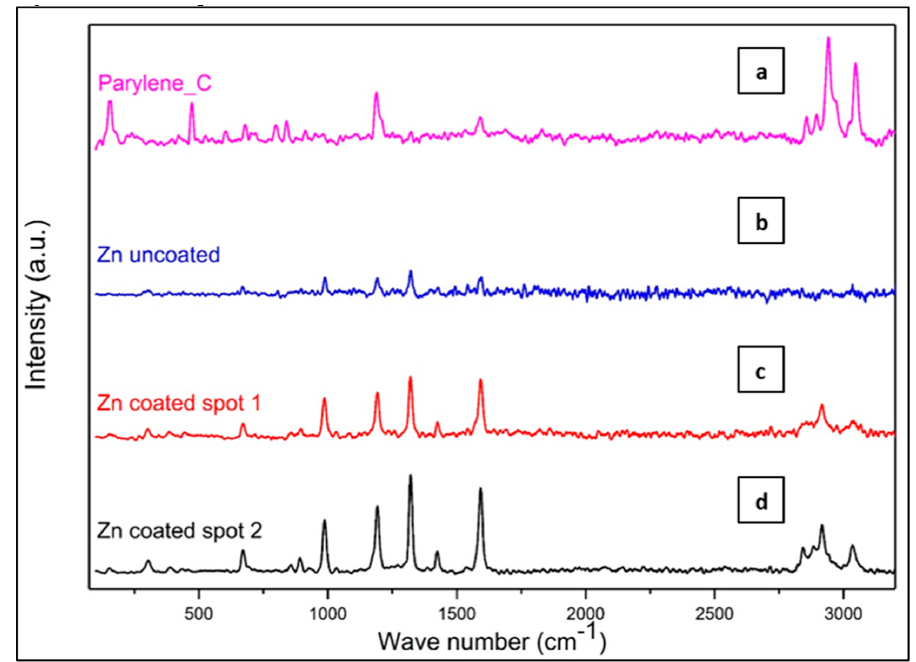
Figure 10. Raman spectroscopy of: ( a ) Parylene_C Dimer as a control; ( b ) Uncoated Zn metal; ( c ) Parylene C-coated stent on random spot 1; ( d ) Parylene C coated stent on random spot